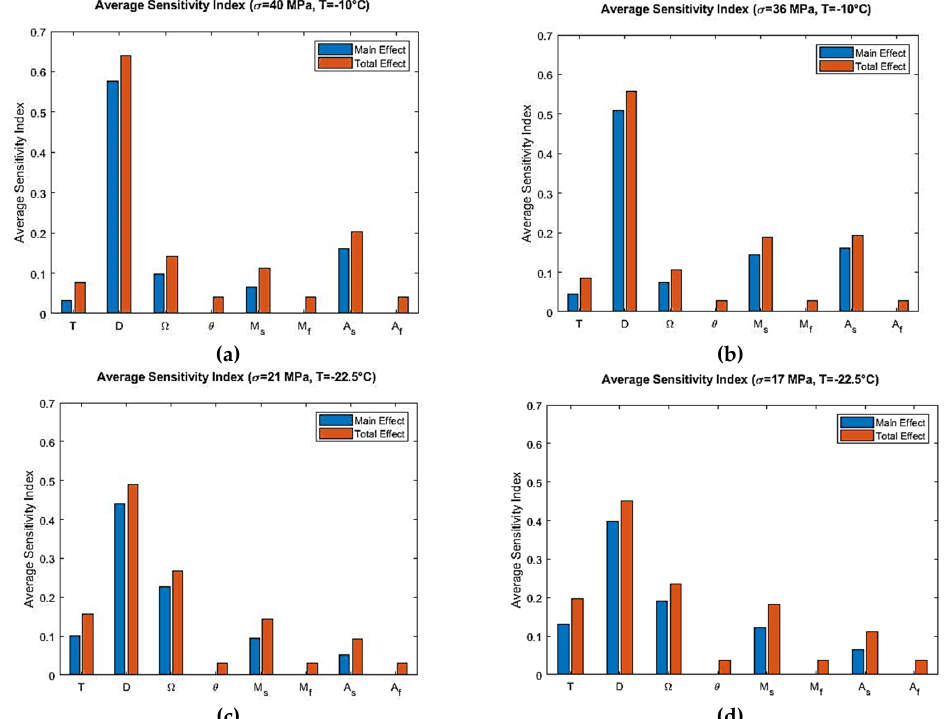
Figure 7. eFAST average sensitivity indices at simulated temperatures and maximum loading stress for the Tanaka model: ( a ) T = − 10 ◦ C, σ max = 40 MPa; ( b ) T = − 10 ◦ C, σ max = 36 MPa; ( c ) T = − 22.5 ◦ C, σ max = 21 MPa; ( d ) T = − 22.5 ◦ C, σ max = 17